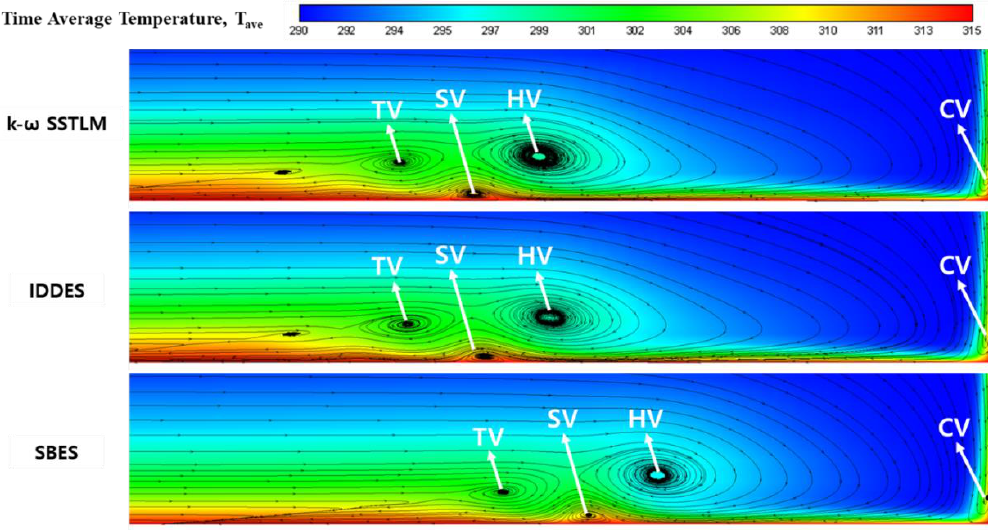
Figure 12. Time-averaged streamlines colored by T ave in front of the first row of pins. HV, horseshoe vortex; SV, secondary vortex; TV, tertiary vortex; CV, corner